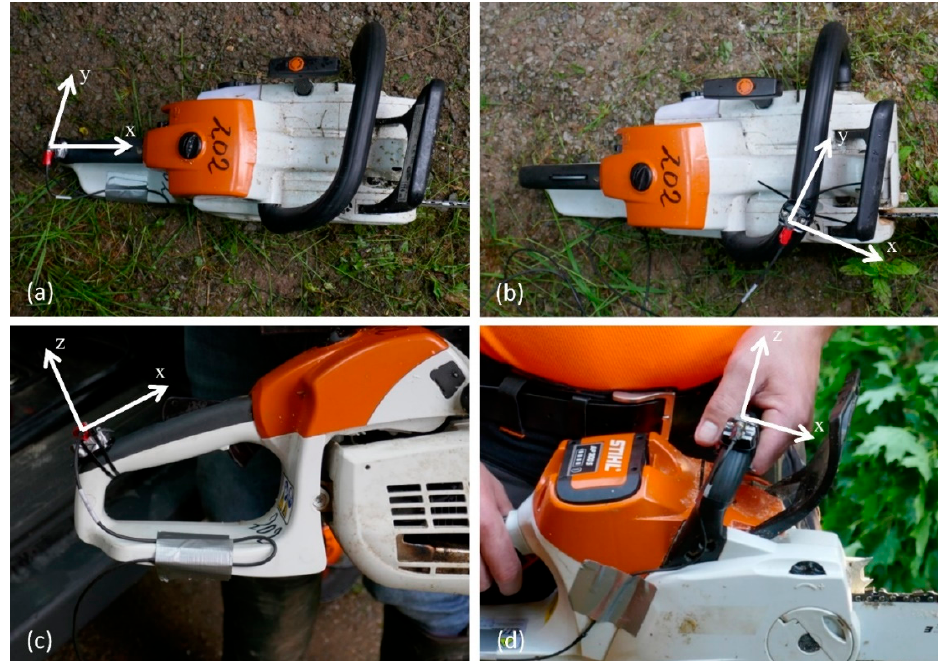
Figure 1. Visualization of the basicentric coordinate system used for the vibration measurements when the sensor is mounted on the rear and front handle. ( a ) Rear handle top view; ( b ) front handle top view; ( c ) rear handle side view; ( d ) front handle side view.